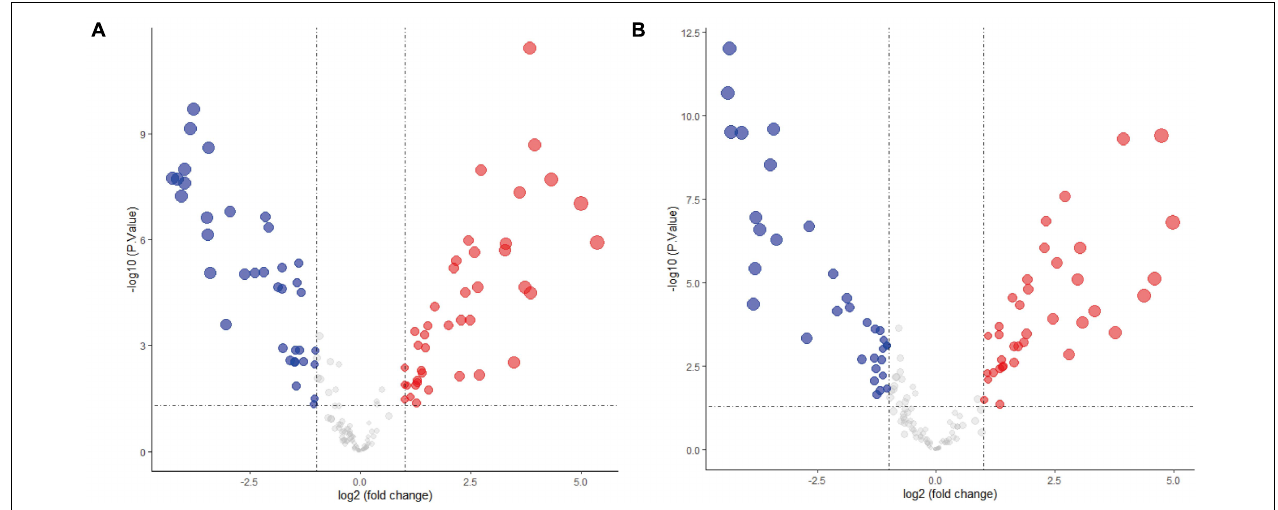
Frontiers in Cell and Developmental Biology |